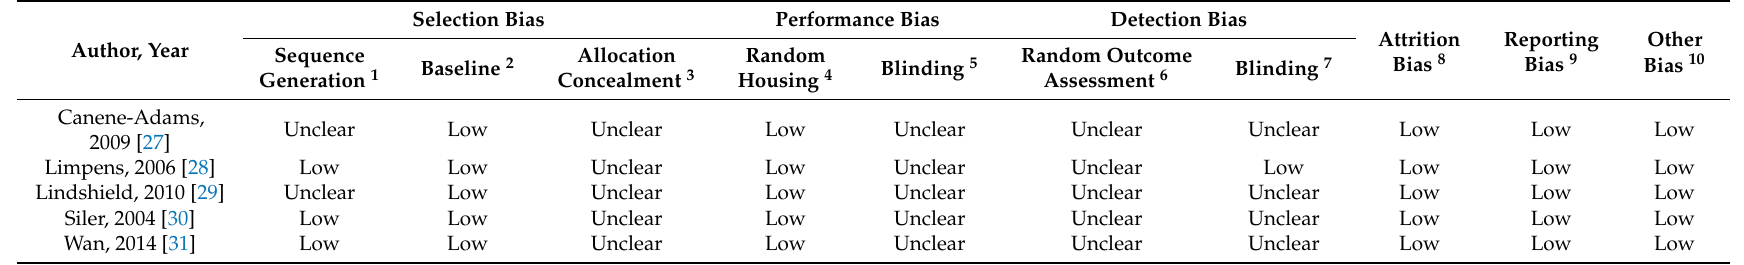
Table A1. Quality assessment of included animal studies (SYRCLE tool) [24].